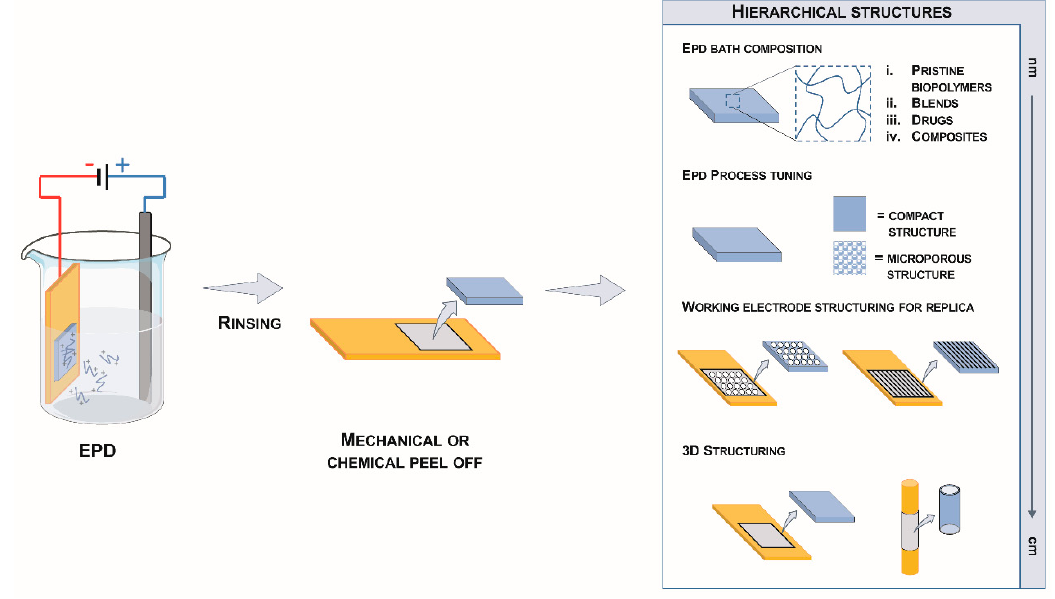
Figure 7. Scheme of the electrophoretic replica deposition process (EPrD).